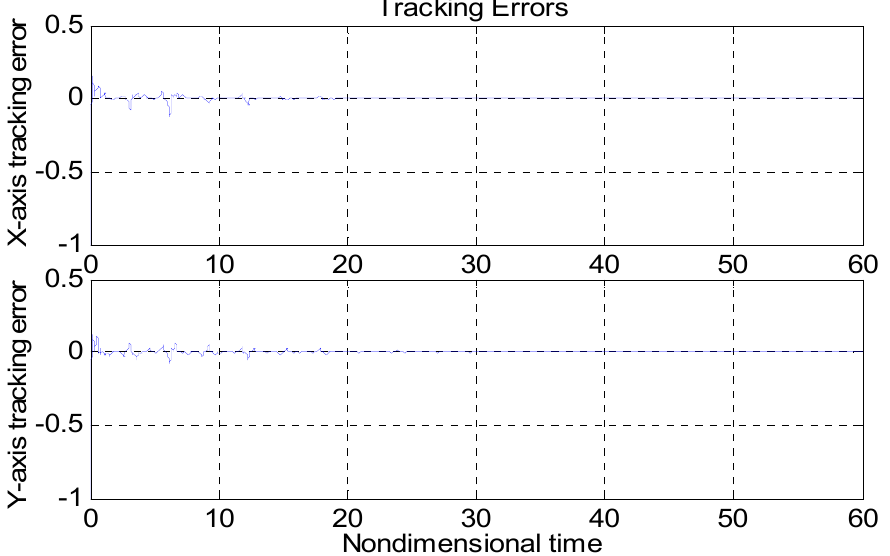
Figure 9. Tracking errors using the adaptive backstepping control approach.